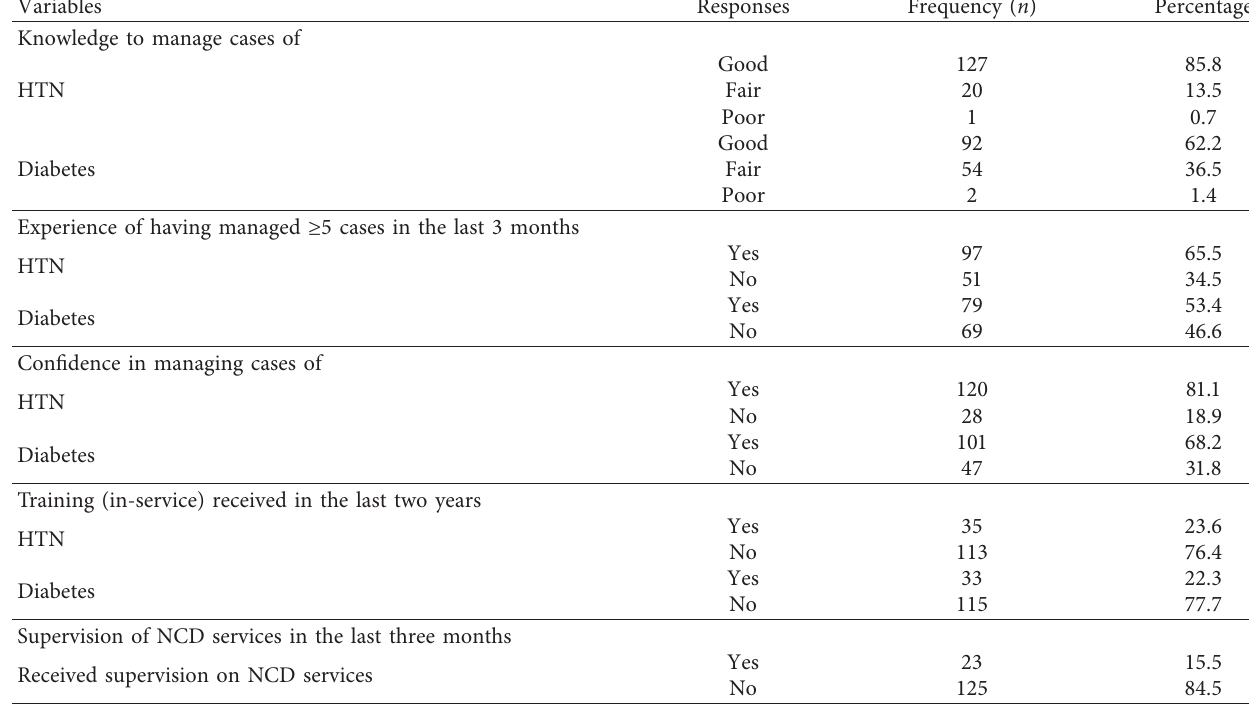
Table 5: Univariate analysis on healthcare workers’ readiness parameters.